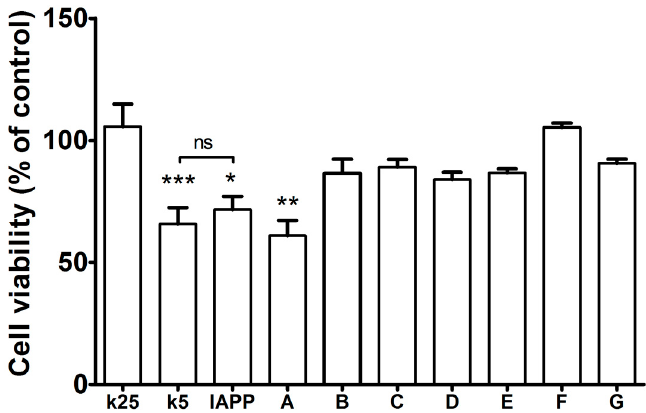
Figure 8. Effect in cells survival at increasing concentrations of hIAPP 1–37 oligomer: We added increasing concentrations of hIAPP 1–37 and observed apoptosis statistically different with the dose of 80 µ mol/L. We verified that the concentrations of DMSO used to dilute the chaperones did not interfere in the cell viability by itself. We also verified that the dose of the vehicle where the hIAPP 1–37 was diluted did not interfere in cell viability. CGN cells were treated with 80 µ mol/L of hIAPP 1–37 cytotoxic oligomers plus 40 µ mol/L of each chaperone. All conditions, except K5, were incubated with DMSO 0.8%. K25 and K5 are potassium 25 mmol/L (normal) and 5 mmol/L (toxic), respectively as controls; * p < 0.05, ** p < 0.01, *** p < 0.001 when compared with K25 as control. One-way ANOVA and post-hoc Newman-Keuls Multiple Comparison Test. hIAPP 1–37 cytotoxic oligomers treatment as well as K5 reduces in approximately 50% CGN viability. Chaperones prevent neuron cell death, except for Chaperon A